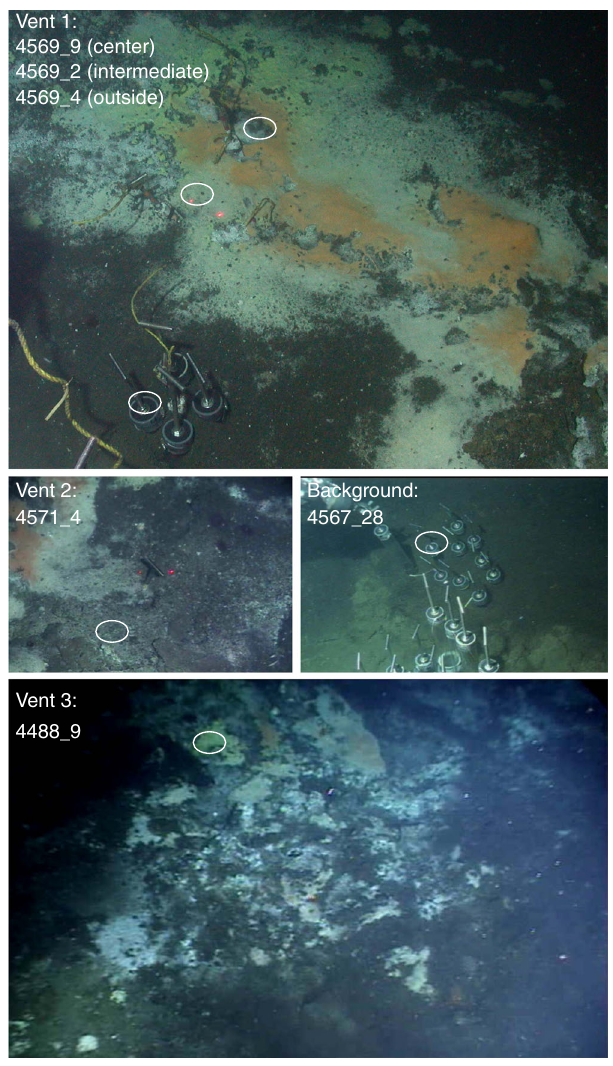
Fig. 1 Overview of sampling sites. In-situ photos of the three hydrothermal sampling sites (Vent1, Vent2, Vent3) and the non-hydrothermal background sediment, including Alvin dive and core number for the sediment cores that were used for DNA extraction and metagenomic analysis. White circle: spots where sediment cores were retrieved by push coring. For Vent1, three sediment cores were taken inside the yellow mat (4569_9), further outside in a white mat area (4569_2) and outside of the mat area (4569_4); next to each core a thermal logging probe was inserted into the sediment. At Vent2 and Vent3, one core each (4571_4 and 4488_9) was sampled. Metadata for all samples are summarized